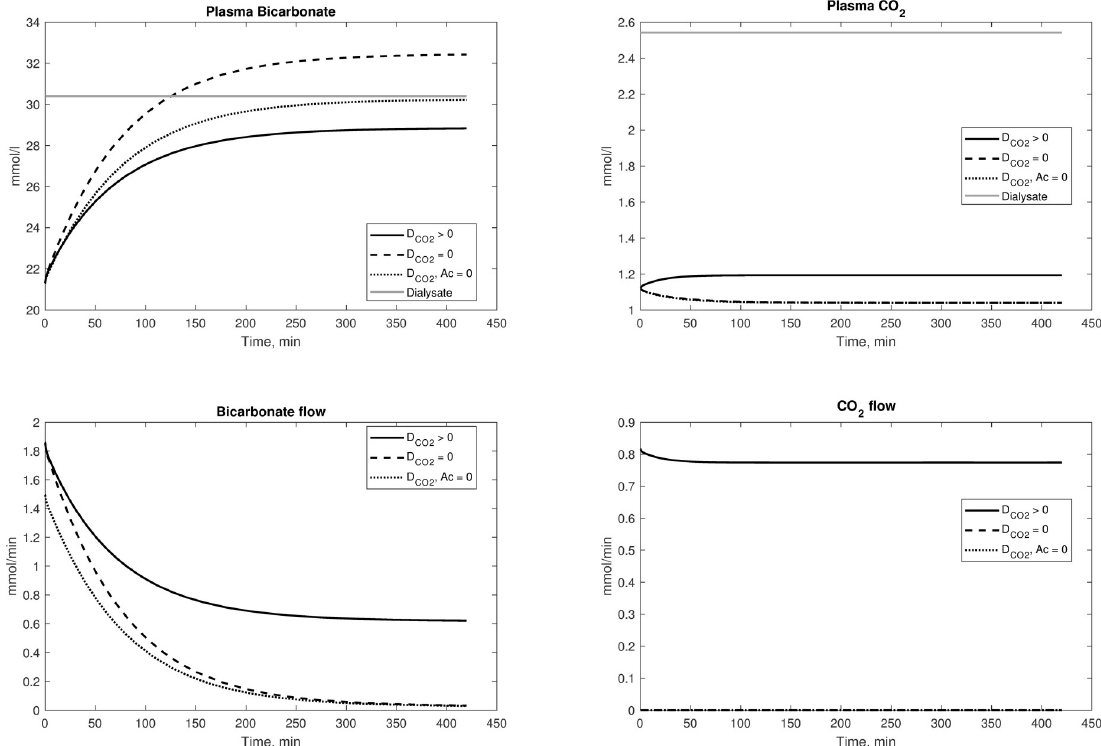
Fig 6. Effects of decreasing D CO2 . (Top) Bicarbonate and dissolved CO 2 concentrations in Sargent data (assuming constant respiration rate), with dialysate concentration of bicarbonate corrected for the Gibs-Donnan effect. The simulated session was extended to 420 minutes to better show the leveling off of bicarbonate concentration profile, and the effects of hemoconcentration were removed by setting the value of UF to zero. Note that if acetate concentration is not set to zero (dashed line), plasma bicarbonate can exceed dialysate concentration because of the constant inflow from acetate, which in the model is independent of other variables. (Bottom) Solute flow rates from dialysis fluid to plasma.